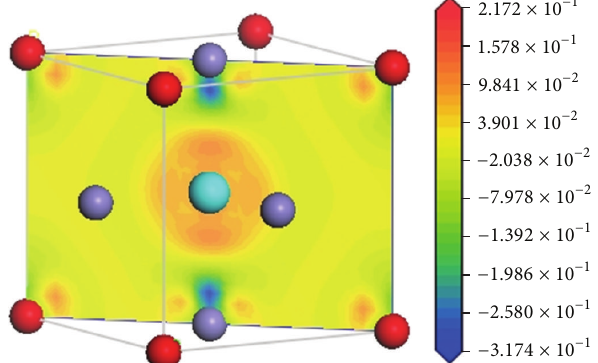
Figure 4: Electron density difference map of the tridiagonal plane with Fe-I and N bonds at 𝑎 = 3.772 ˚A.